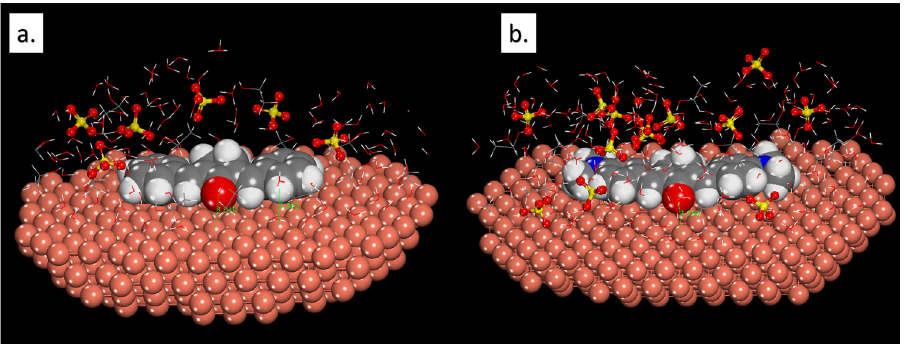
Figure 6: Views of the most stable adsorption con fi guration for Cu ( 111 ) / ( a ) M1 or ( b ) M2 ( b ) /25 ethanol molecules and 60 hydronium + 30 sulfate - simulated corrosion media obtained via MD simulations.